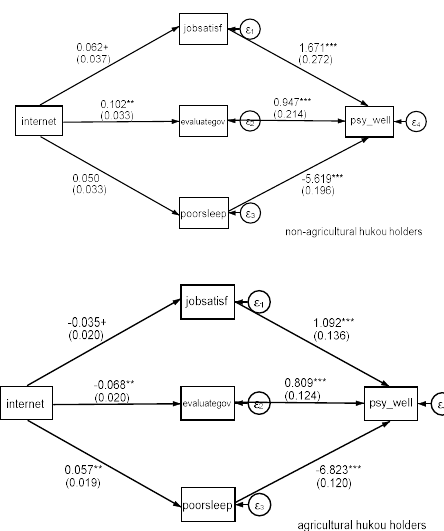
Figure 2. Graphical representation of the linear structural equation model in Table 5 (including the control). *** p < 0.001, ** p < 0.01, + p < 0.1.